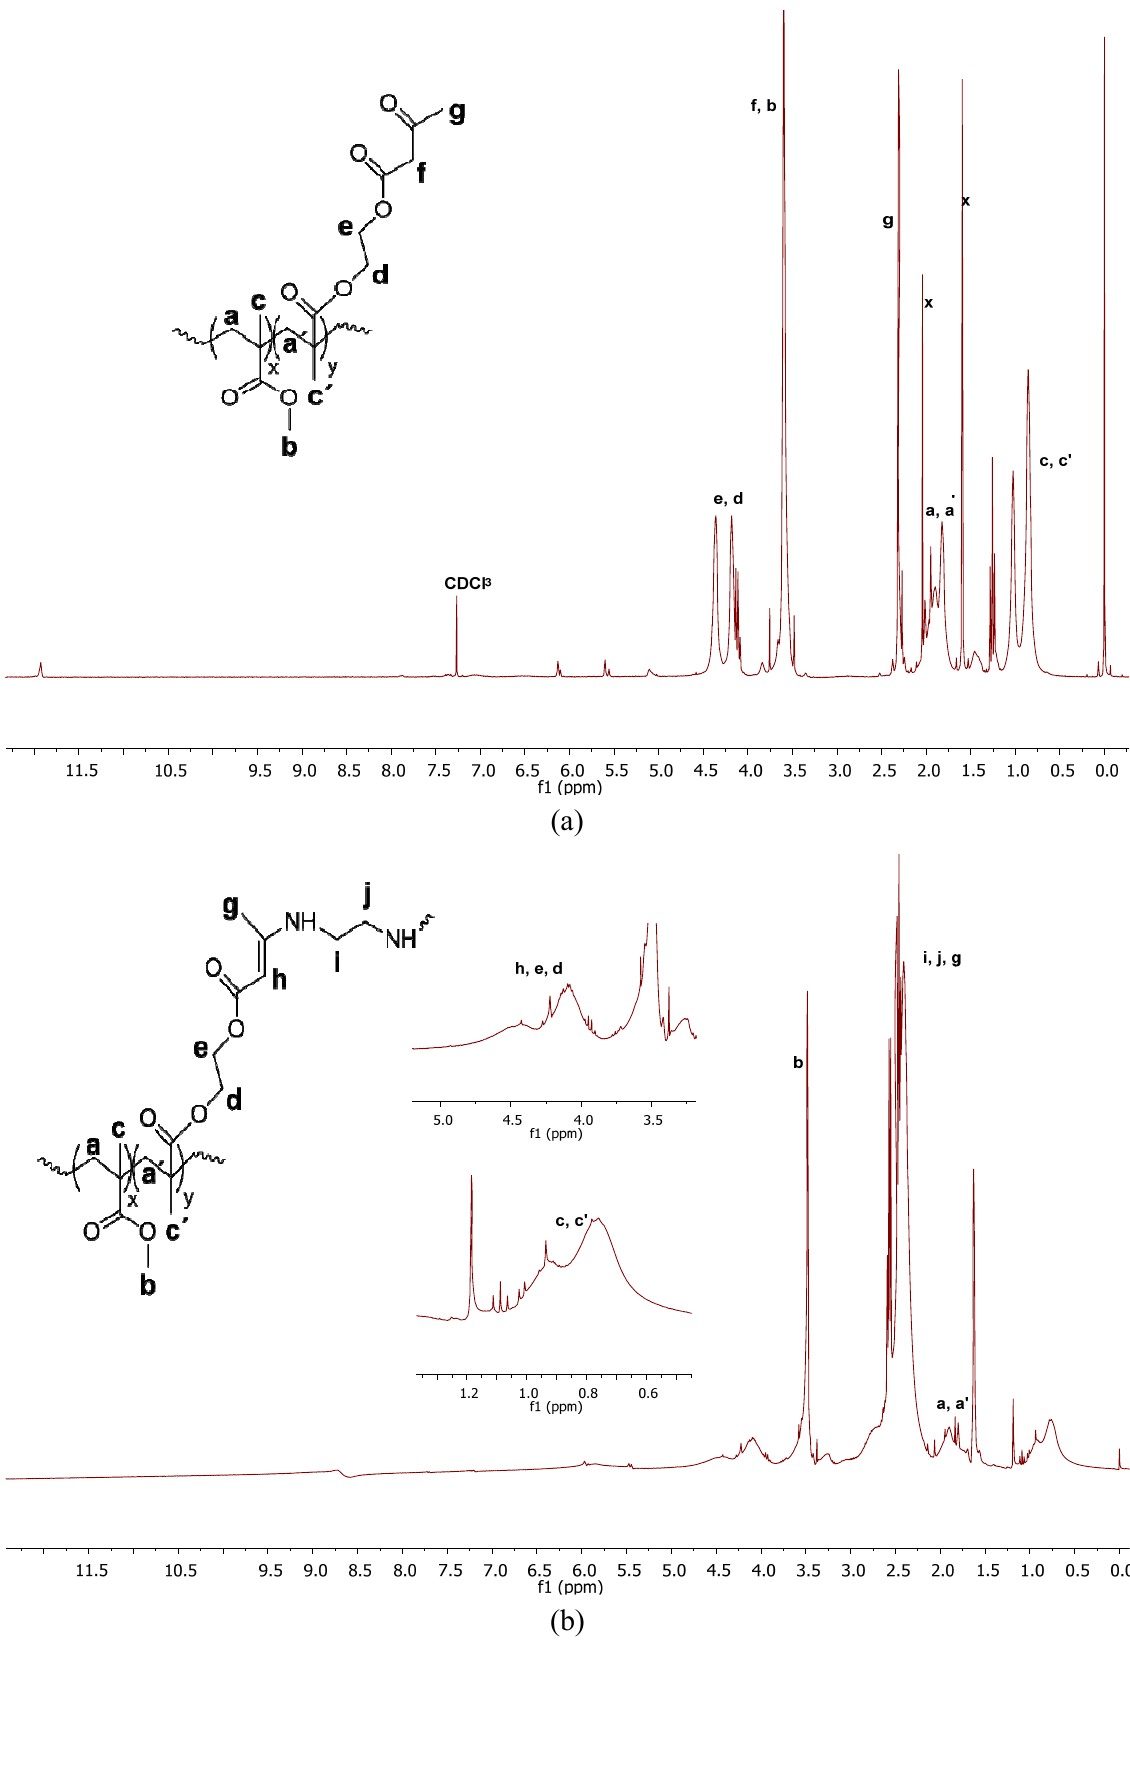
of the PMMA-NPs, 2a , synthesized by 8 8